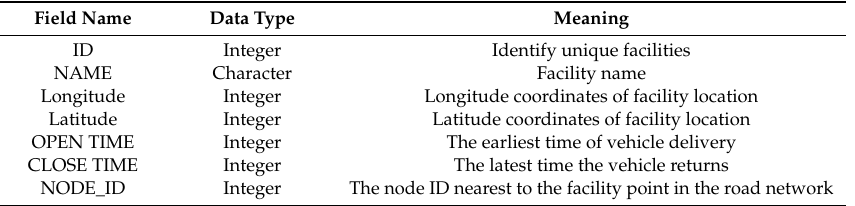
Table 1. Facility point data type table.